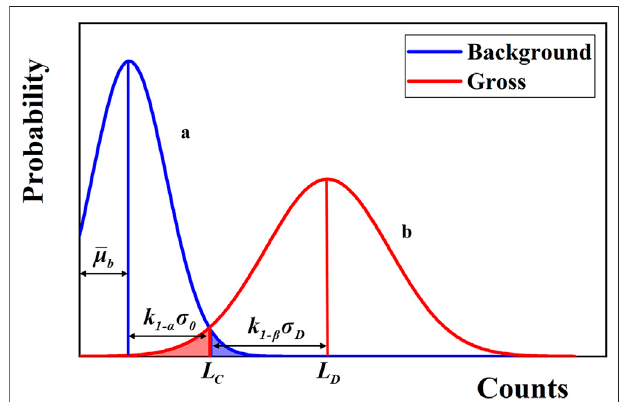
FIGURE 2 | Schematic diagram of two types of errors. The Gaussian- shaped curves in blue and red represents the probability distributions of counting statistics for measurements on background and sample (under the same background), respectively. The shaded parts denote the probability of the fi rst (blue) and second (red) type of errors,